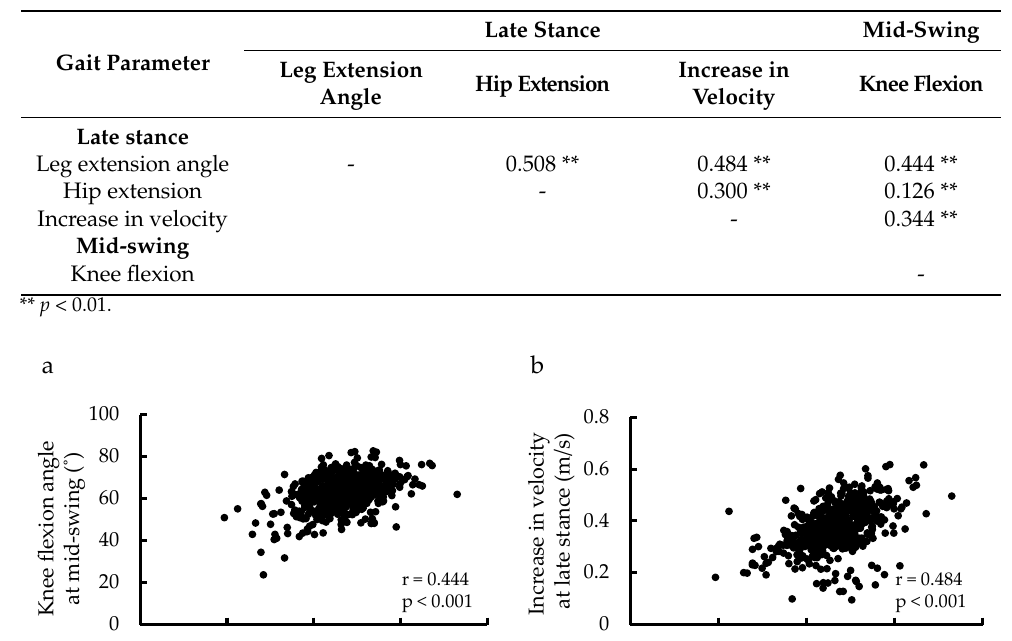
Table 1. Correlation coefficients between leg extension angle and gait parameters at late stance and swing phase.